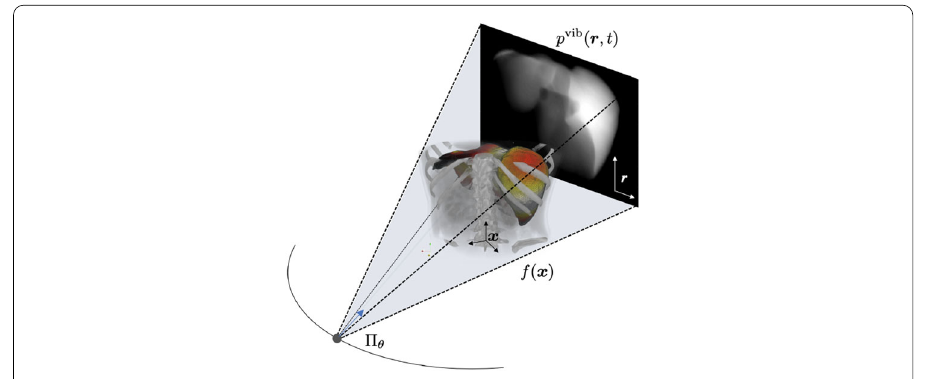
Fig. 1 Scheme of the acquisition procedure. The point-like source (shown as a • ) and the detector may rotate around the sample by an angle